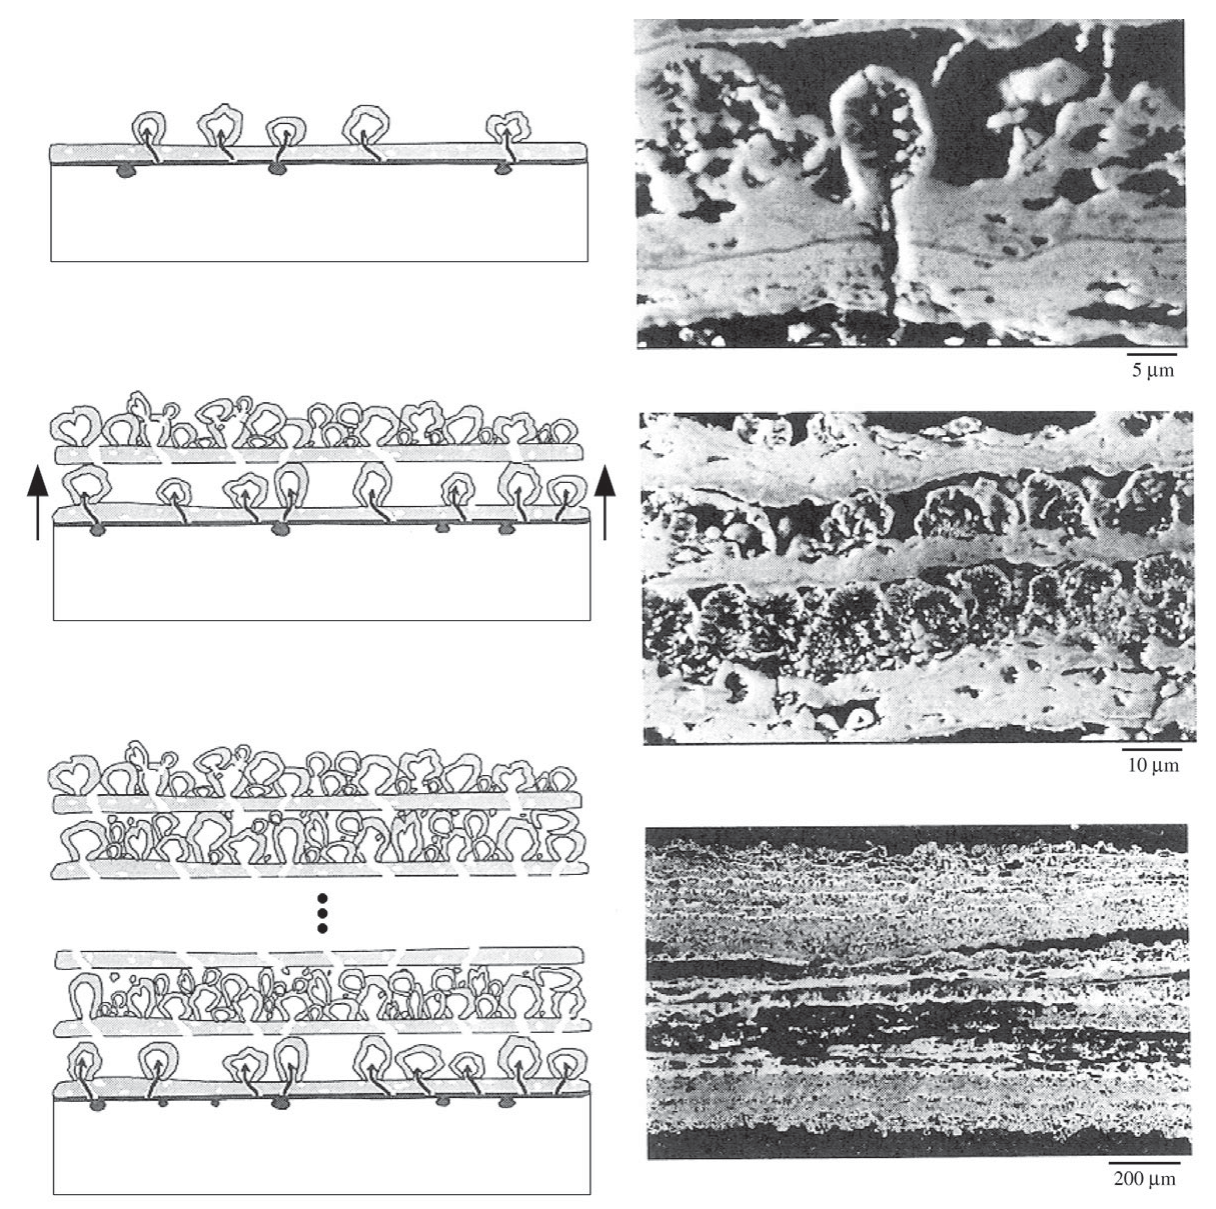
Figure 2. Growth of multilayered oxide scales by active oxidation of Cr, Fe-15% Cr, Fe-35% Cr, Fe-15% Cr-5% Ti etc.; a) schematic model; b) scale grown on Fe-15% Cr-5% Ti after 168 h in N